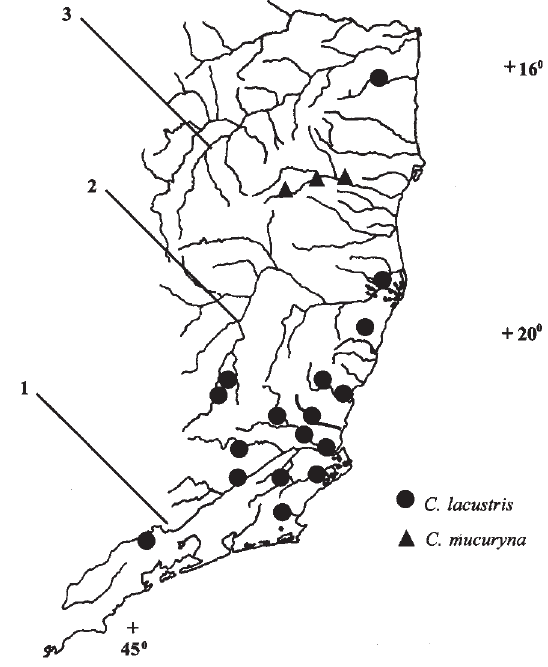
Fig. 2. Collecting localities of Crenicichla lacustris and